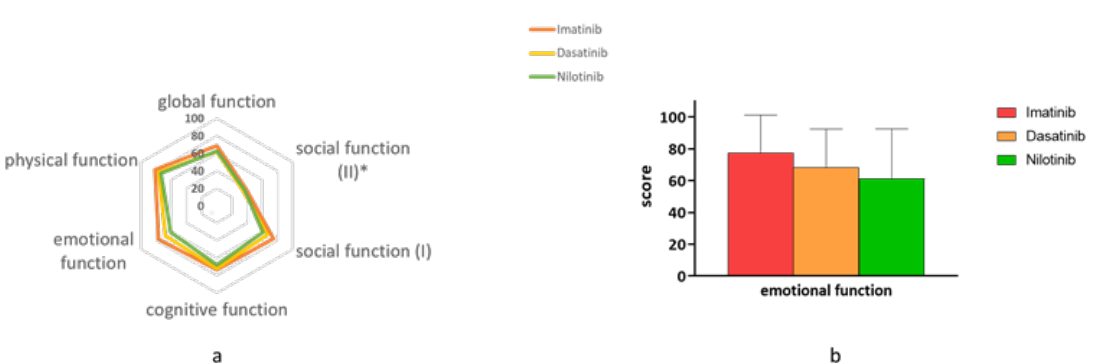
Figure 2. Functional Status on imatinib vs. dasatinib and nilotinib. Functional status according to QLQ30 and CML-24 in patients on imatinib, dasatinib or nilotinib. ( a ) A polar plot summarizes scores of 5 different aspects of function according to patient reports. Social function is represented in 2 scales (QLQ30 and CML-24). As shown, patients on imatinib are represented in the outer circle, indicating better function. ( b ) A bar graph showing that patients on imatinib report higher levels of emotional functioning. European Organization for Research and Treatment of Cancer Quality of Life Core Questioner 30 (EORTC QLQ-C30); European Organization for Research and Treatment of Cancer Quality of Life Questioner of Chronic myeloid Leukemia 24 (EORTC